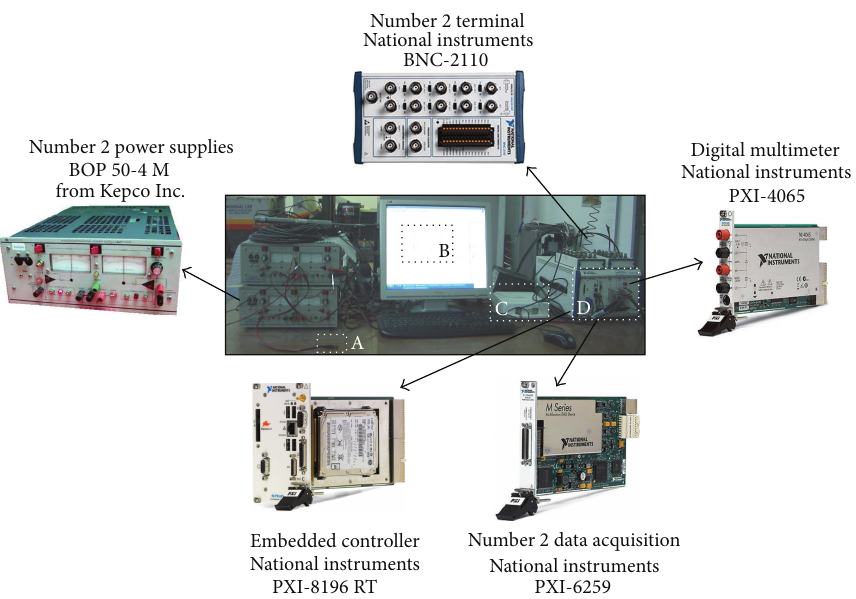
Figure 2: Electronic equipment for acquisition and control during the JET-PACS experimental tests.